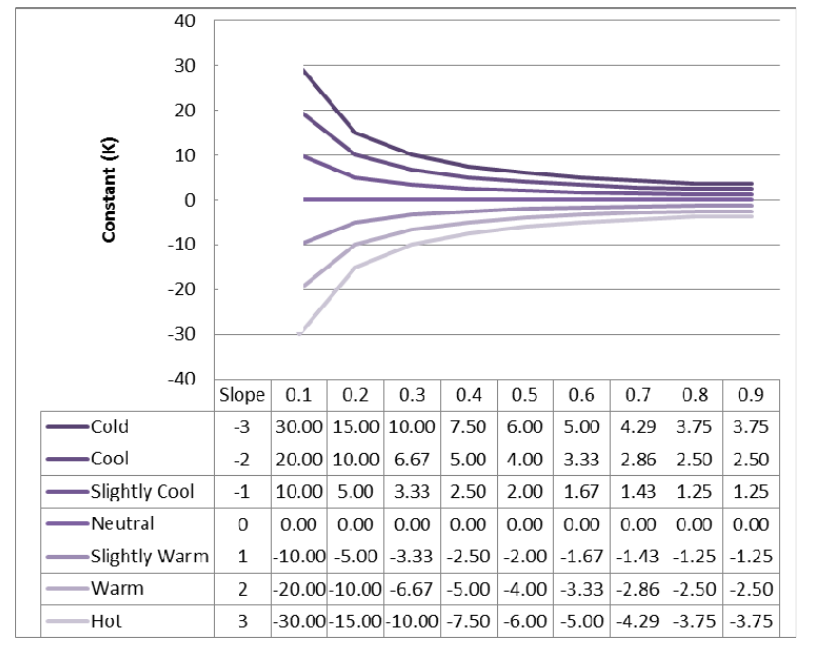
Figure 7. The developed constant k (constant) from the Griffiths